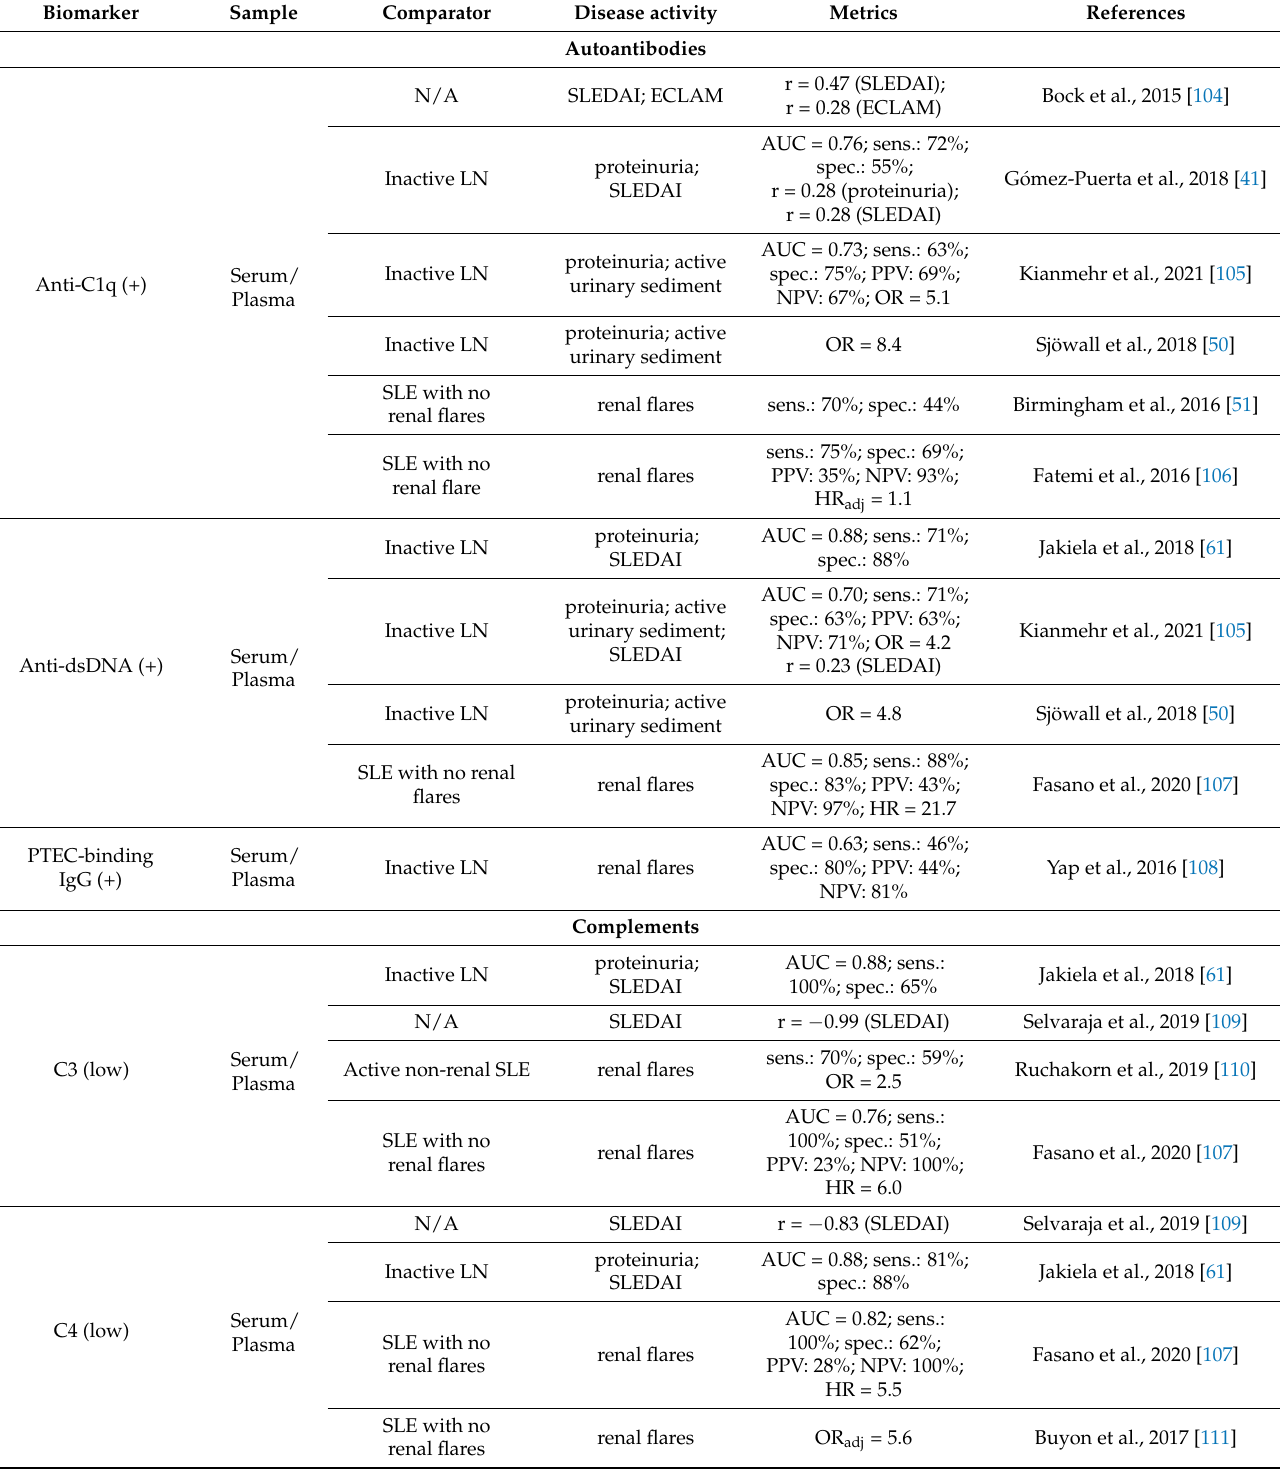
Table 2. Performances of selected biomarkers of clinical disease activity in